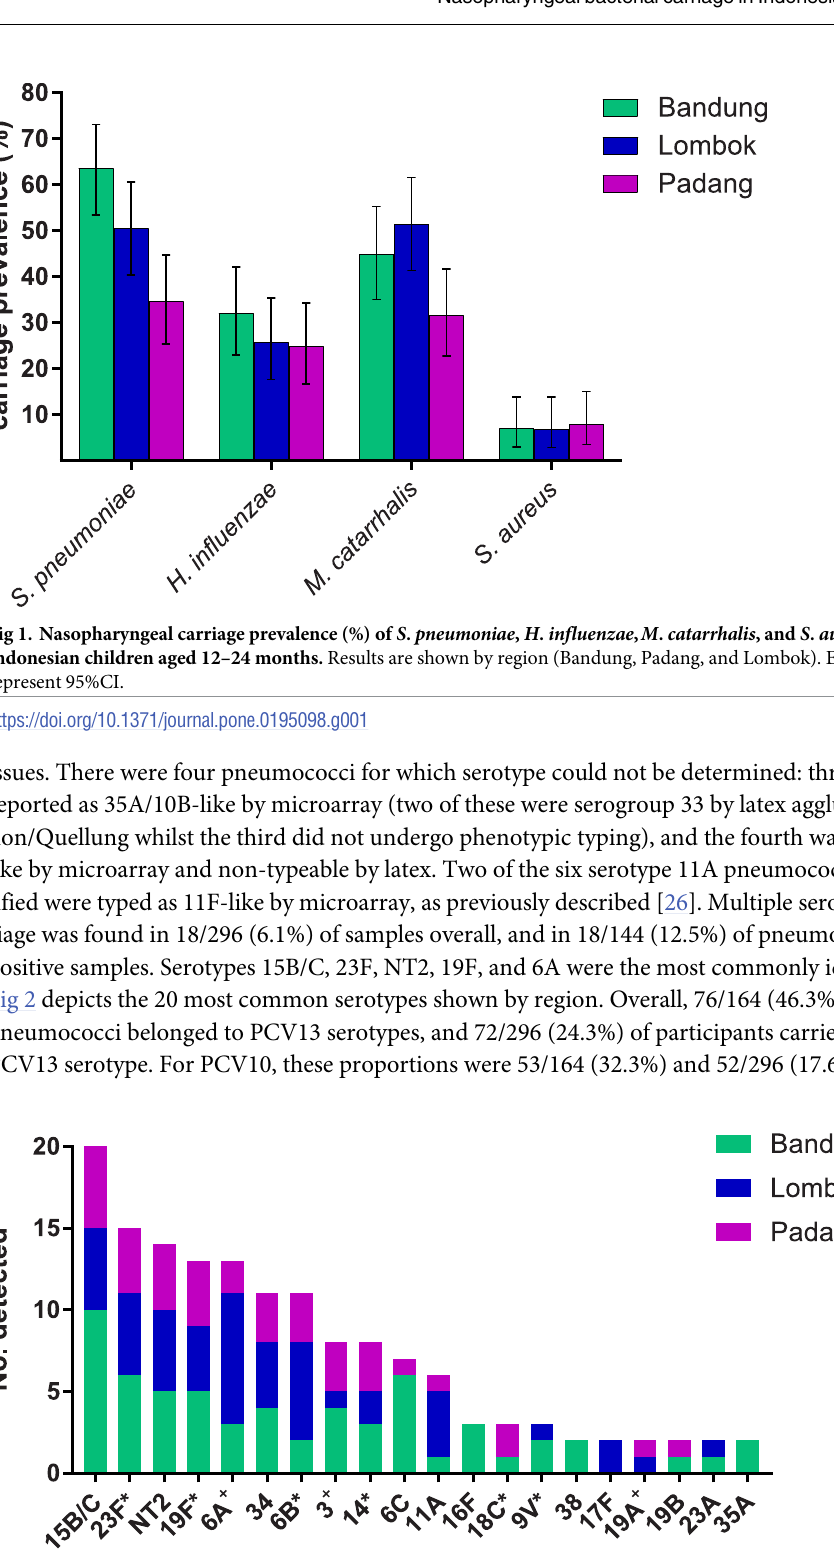
Fig 2. The twenty most common pneumococcal serotypes identified in nasopharyngeal swabs collected from Indonesian children aged 12–24 months, shown by region (Bandung, Padang, and Lombok). (cid:3) indicates serotypes included in PCV10 and + indicates the additional three serotypes included in